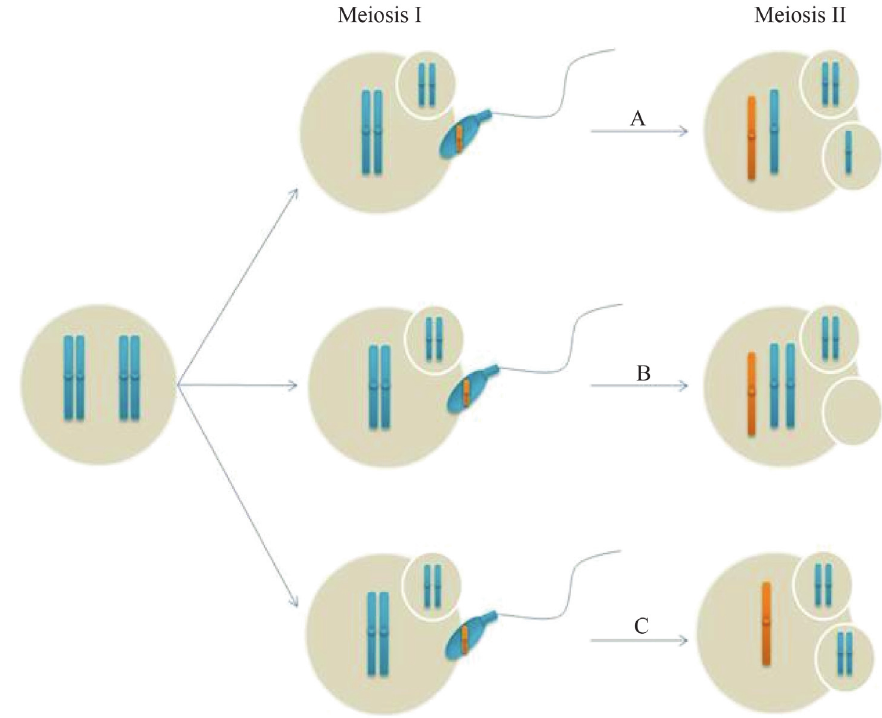
Figure 1 - Possibilities of segregation during the second division from a normal oocyte. One of the three possibilities is normal